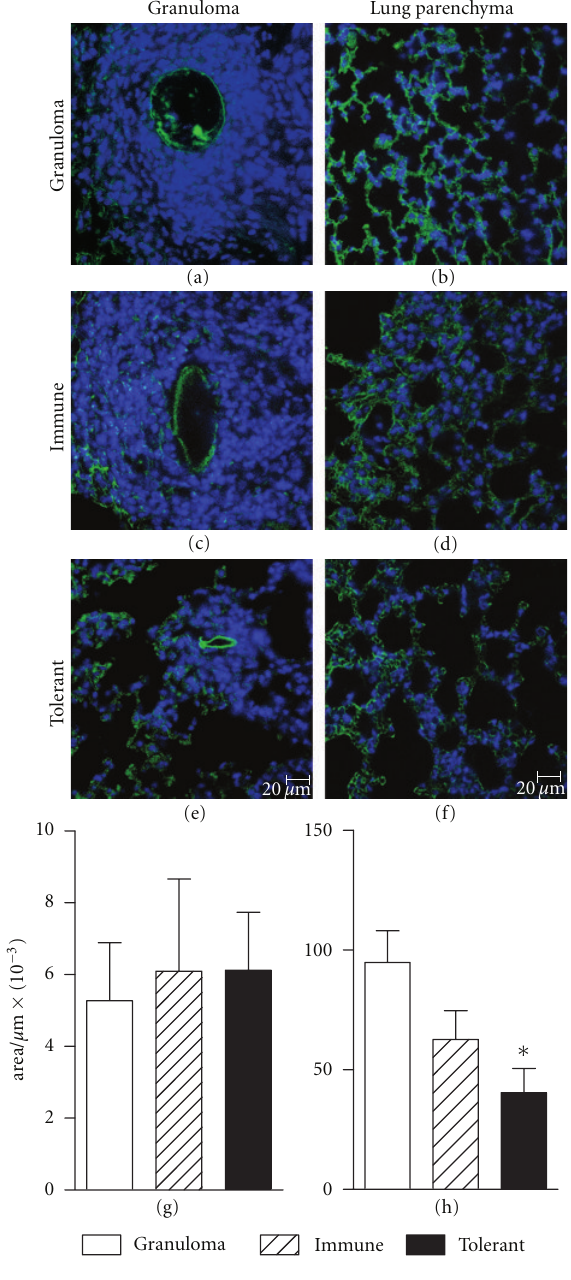
Figure 5: Re-exposure of orally tolerant animals to the tol- erated antigen block the rise of ICAM-1 expression in lung parenchyma. Immunolocalization of ICAM-1 in granulomas and lung parenchyma using specific antibody coupled with fluores- cein (green) and nuclear counterstainig with 4 (cid:5) 6-diamidino-2- phenylindol (blue), 18 days after i.v. eggs injection. Confocal microscope images were captured with a 63X objective, and the graphs represent the green fluorescence intensity (the sum of gray values of all pixels divided by the area (in μ m 2 ) × 10 − 3 ) of expression of ICAM-1 in the granuloma area (a–d) and in lung parenchyma (e–h) in nonimmunized mice (granuloma group, open bars), OVA immune controls (hatched bars), and OVA-orally tolerant mice (black bars). Data represent mean ± SEM of fluorescence intensity of duplicate slides ( n = 5